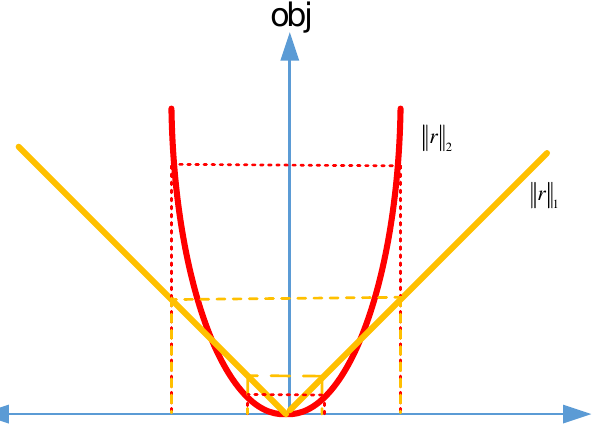
Figure 4. Responses of l 1 and l 2 norm approaches vs. residual.